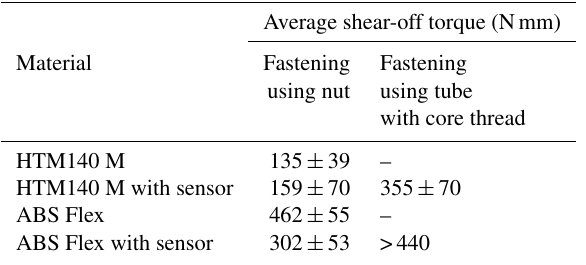
Figure 8. Photographs of sheared-off screws: ABS Flex screw with integrated sensor (a) , ABS Flex screw without integrated sensor (c) , HTM140 M screw with integrated sensor (b) , and HTM140 M screw without integrated sensor (d) . Table 1. Die shear test results for the different materials with and without an embedded sensor